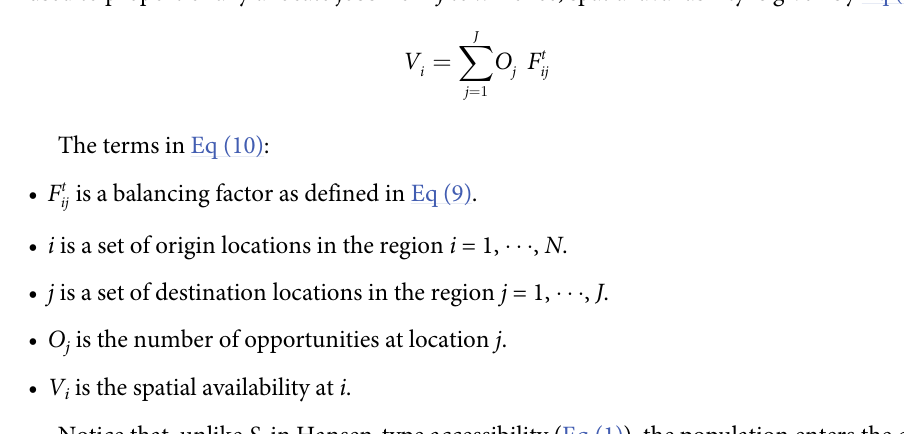
PLOS ONE | https://doi.org/10.1371/journal.pone.0278468 January 20,